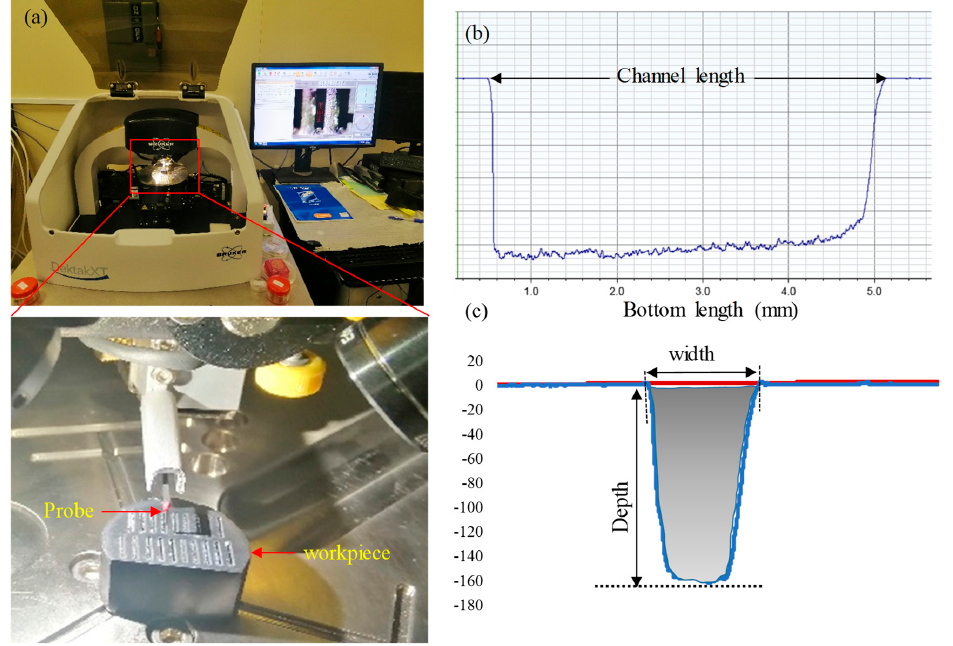
Figure 5. Measuring devices. ( a ) Three-dimensional optical profilometer; ( b , c ) typical geometry of the 2D profile and its cross-sectional area.